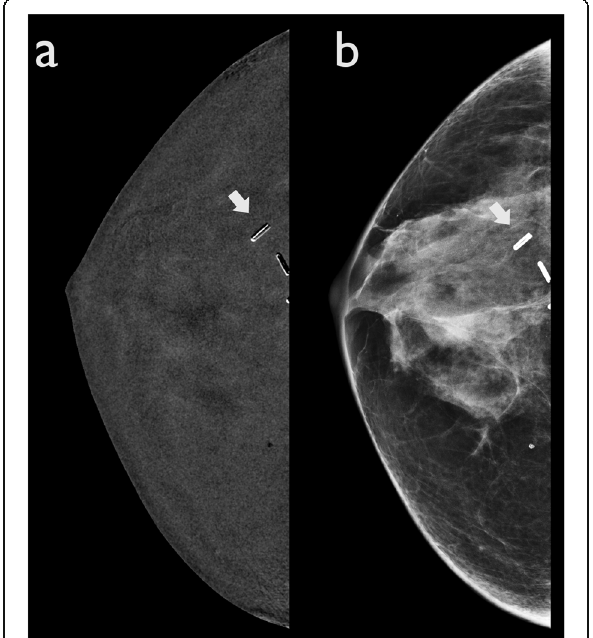
Fig. 12 Misregistration artefact. A woman with a history of previous right quadrantectomy. a CEDM recombined image shows post- surgical clips with alternating bright and dark lines (arrow). b The same clips are also visible in LE CEDM images (arrow)